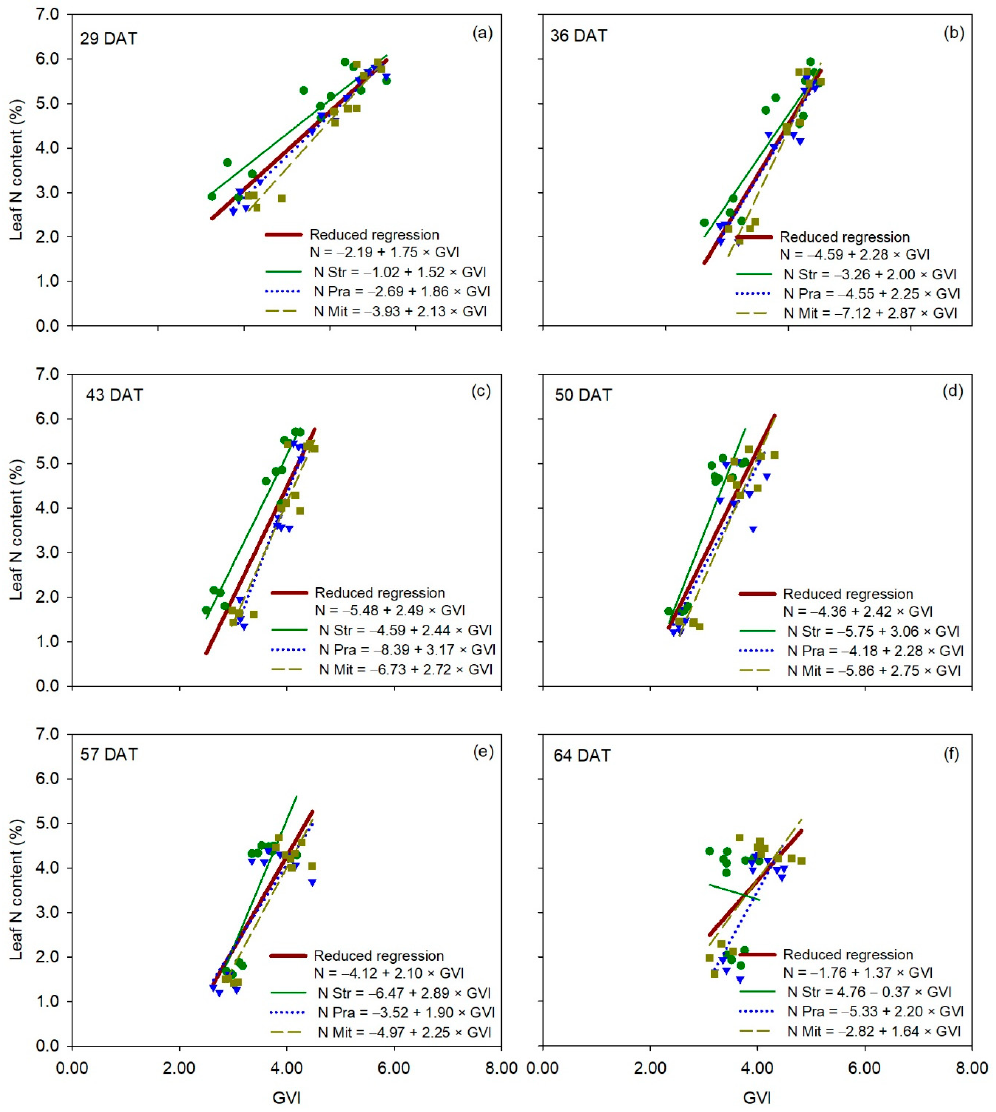
Figure 8. Linear regression between GVI measurements (independent variable) and leaf N content (dependent variable) for each cultivar of cucumber ( Cucumis sativus L.), for each measurement date (panels a – f ). The reduced regression is a regression with data of all three cultivars together. DAT is days after transplanting. Str, ‘Strategos’, Pra, ‘Pradera’, Mit, ‘Mitre’. Table 2. p -values of the F-statistic analysis comparing the relationship between leaf N content and optical sensor measurements between the reduced regression for all three cultivars together and the regression of each cultivar of cucumber ( Cucumis sativus L.) separately. Numbers in bold show significant di ff erences ( p < 0.05) between the reduced regression and the cultivar regression. SPAD CCI NDVI GVI DAT ‘Strategos’ ‘Pradera’ ‘Mitre’ ‘Strategos’ ‘Pradera’ ‘Mitre’ ‘Strategos’ ‘Pradera’ ‘Mitre’ ‘Strategos’ ‘Pradera’